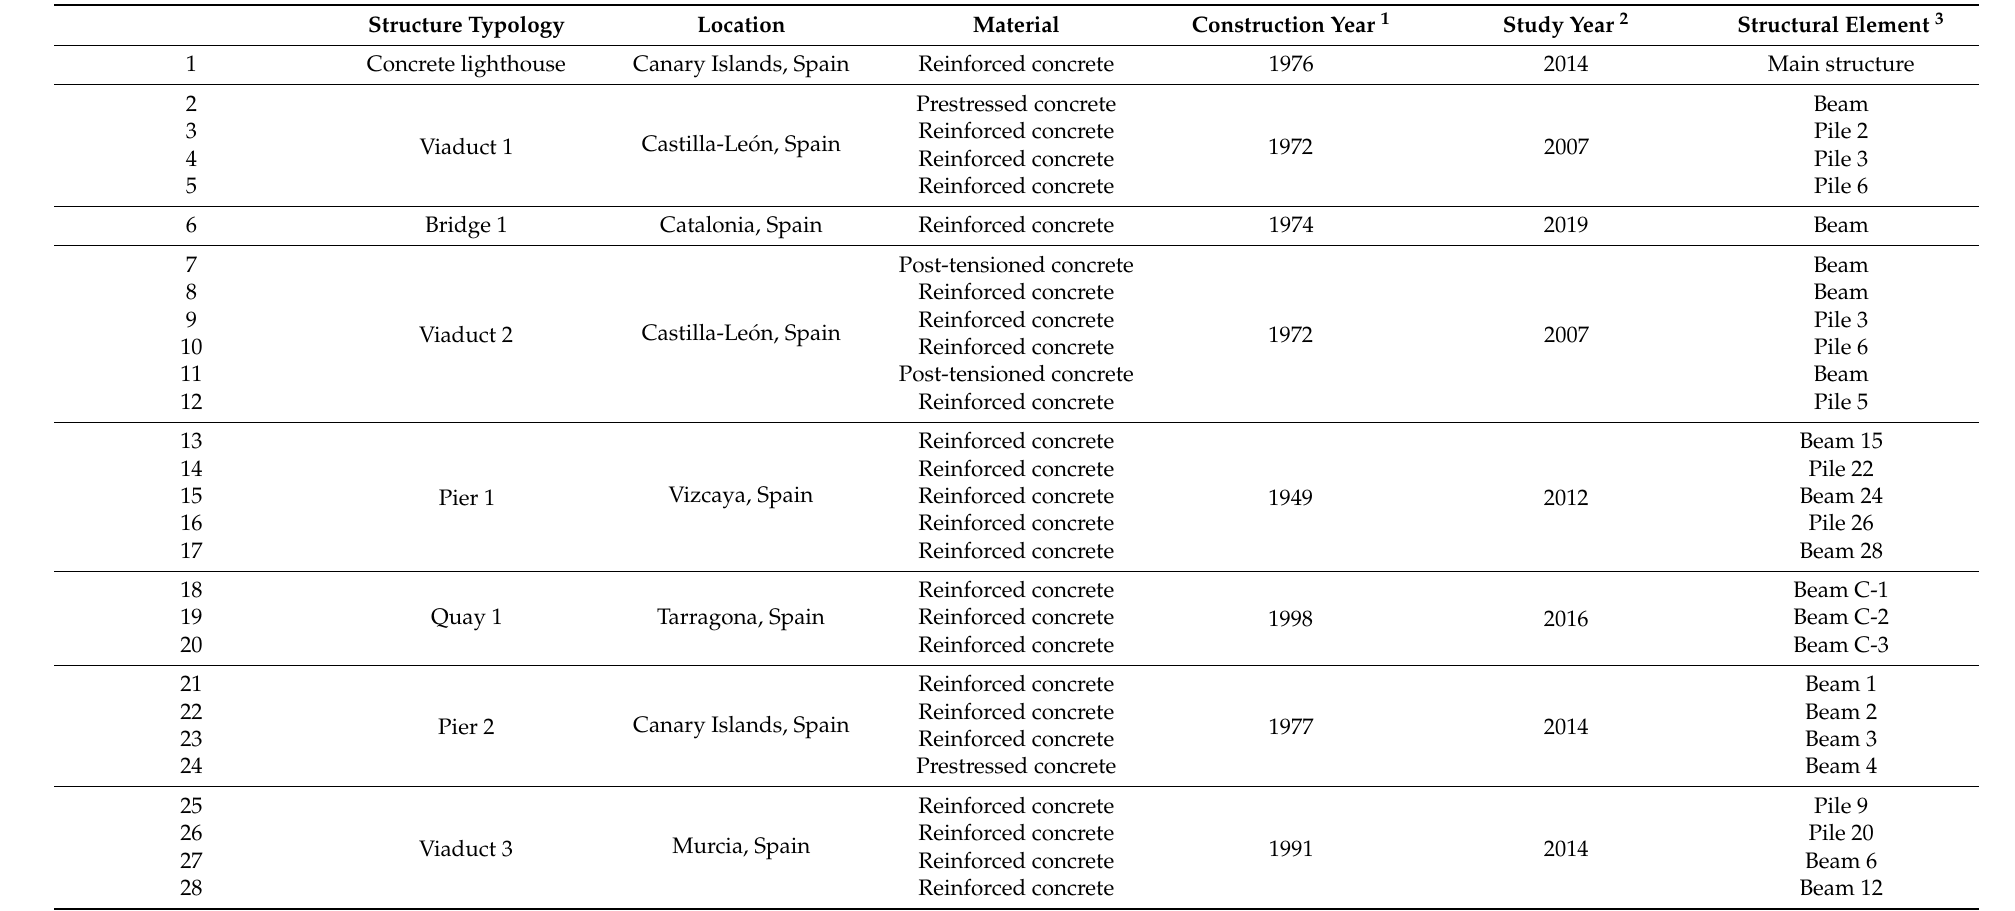
Table 1. General data on the structures selected for the case